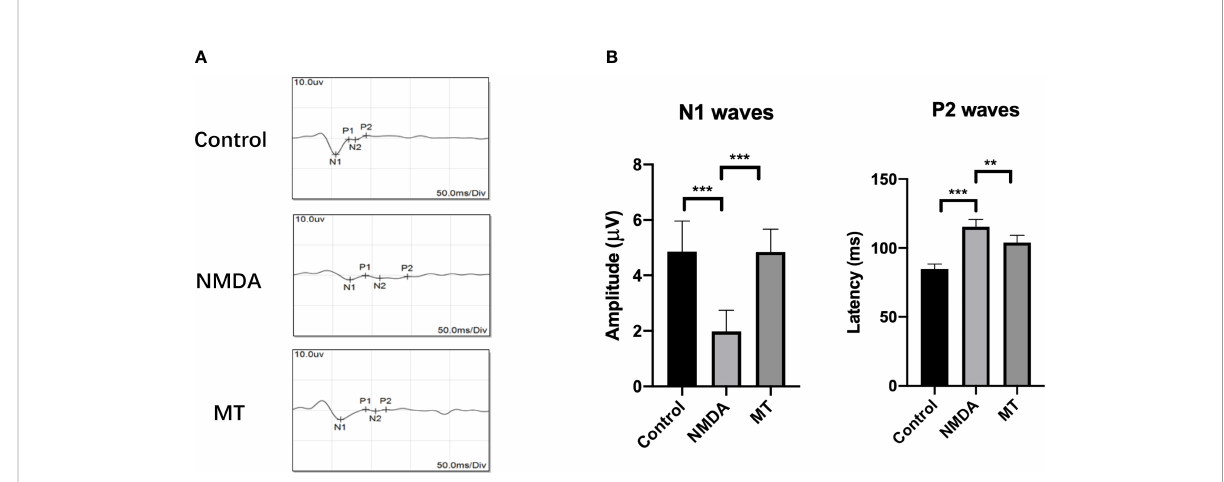
FIGURE 4 MT protects visual function in mice. (A) FVEP images of mice after intravitreal injection of NMDA 5 days. (B) The amplitude of N1 waves and the latencies of P2 waves of FVEPs in mice at 5 days after injection. (n = 6) Data are the mean ± SD; **p < 0.01, ***p < 0.001. Scale bar = 10.0 m V and 50